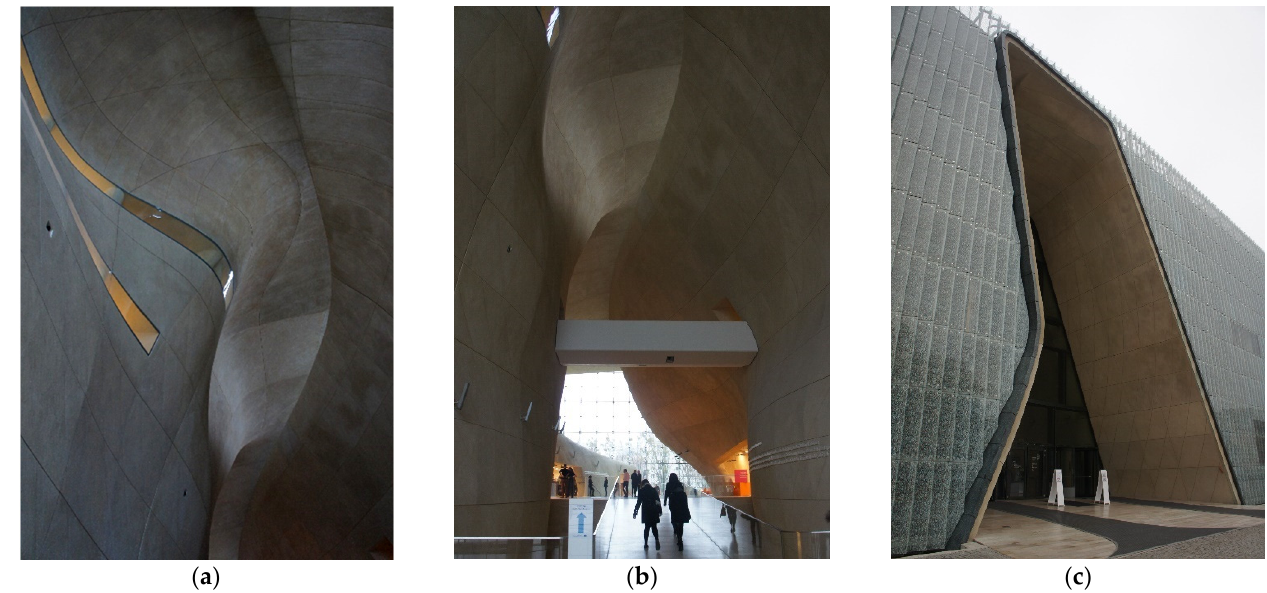
Figure 7. Museum of the History of Polish Jews, POLIN, Warsaw, 2013, Lahdelma and Mahlamäki Architects + Kurylowicz and Associates. ( a ) Enclosure of the main entrance hall made with shotcrete, (photo by M. Celadyn); ( b ) main entrance hall, photo by M. Celadyn); ( c ) main entrance (photo by M. Celadyn).